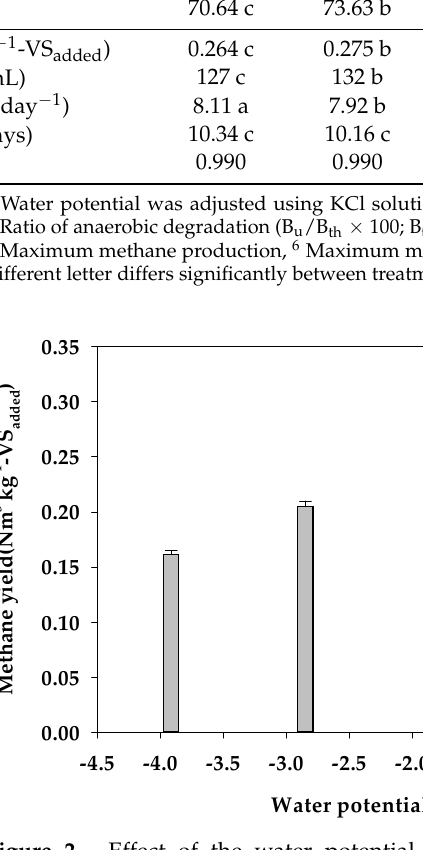
Figure 2. Effect of the water potential ( Ψ ) on the methane yield (vertical bars mean the standard deviations).